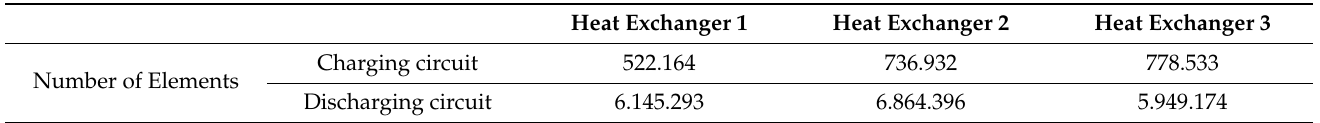
Table 5. Mesh size for the geometries